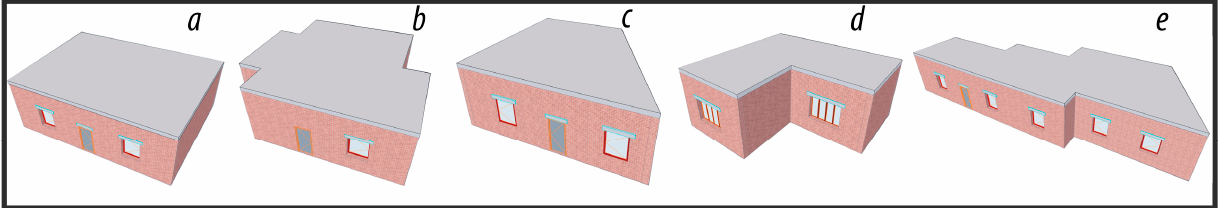
Figure 10. Examples of irregularity in plan: ( a ) Regular, ( b ) Irregular, ( c ) Regular, ( d ) Irregular, ( e ) Extremely irregular.